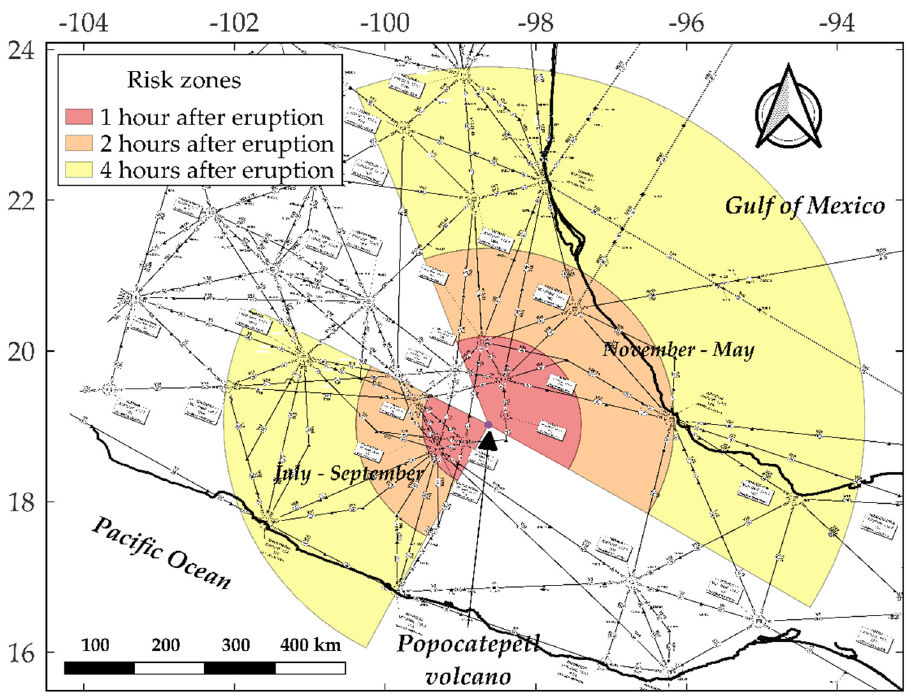
Figure 9. Proposed high frequency areas affected by volcanic ash. The map shows delimited areas considering the movement of a volcanic cloud transported by the wind in the seasons of the year defined by the wind direction. Three areas of safety are identified: the first with a radius considering an hour of displacement by wind speed (red); the second level of safety is defined by two hours of transport at a critical wind speed (orange); the third zone by a transport of 4 h at a critical wind speed (yellow).